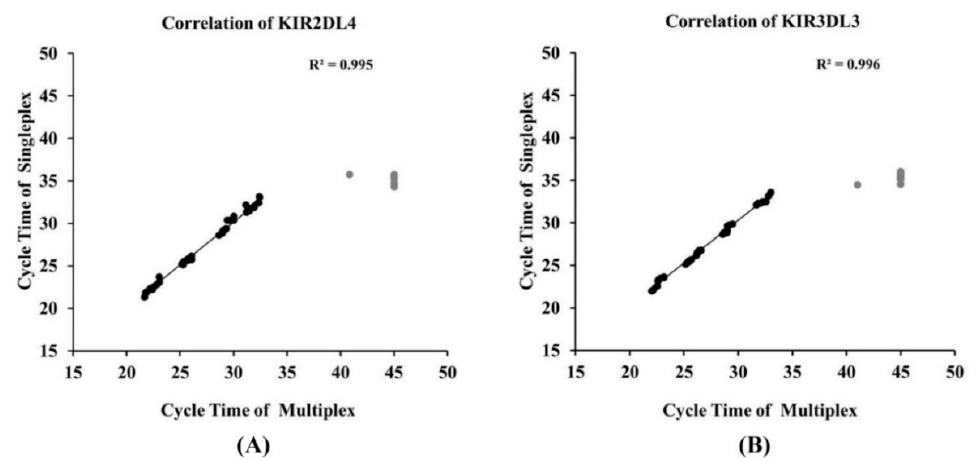
Figure 2. Correlation between the C t values obtained with singleplex and multiplex qRT-PCR assays. The coefficient of correlation ( R 2 ) values for KIR2DL4/3DL3 detections, excluding the outliers marked in gray, were 0.995 and 0.996 for ( A ) KIR2DL4 and ( B ) KIR3DL3 , respectively. Higher variations of the C t values were found if gene templates were fewer than 500 copies for the multiplex, the outlier data which was out of limit of detection (LOD).